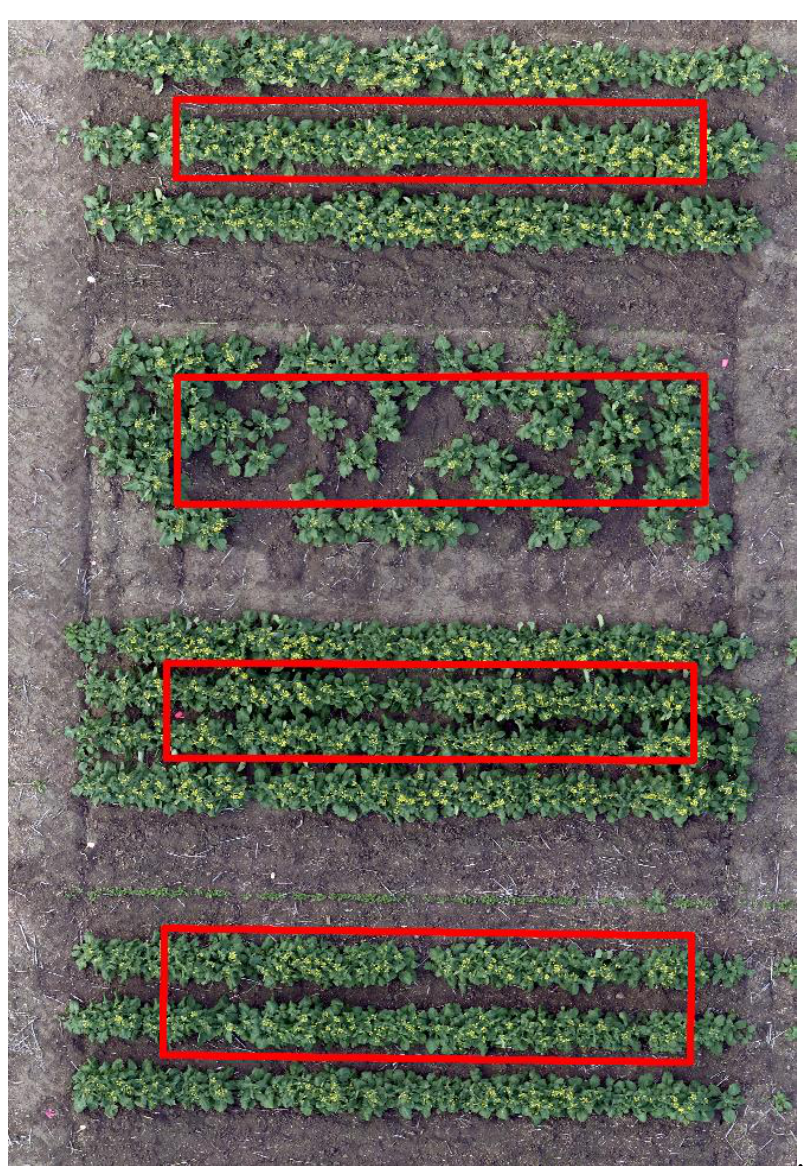
Figure 3. Vector layer used to extract the flower information from the image acquired on 12 July. The red polygon represents the area considered for quantifying canola flower area from the orthomosaics.